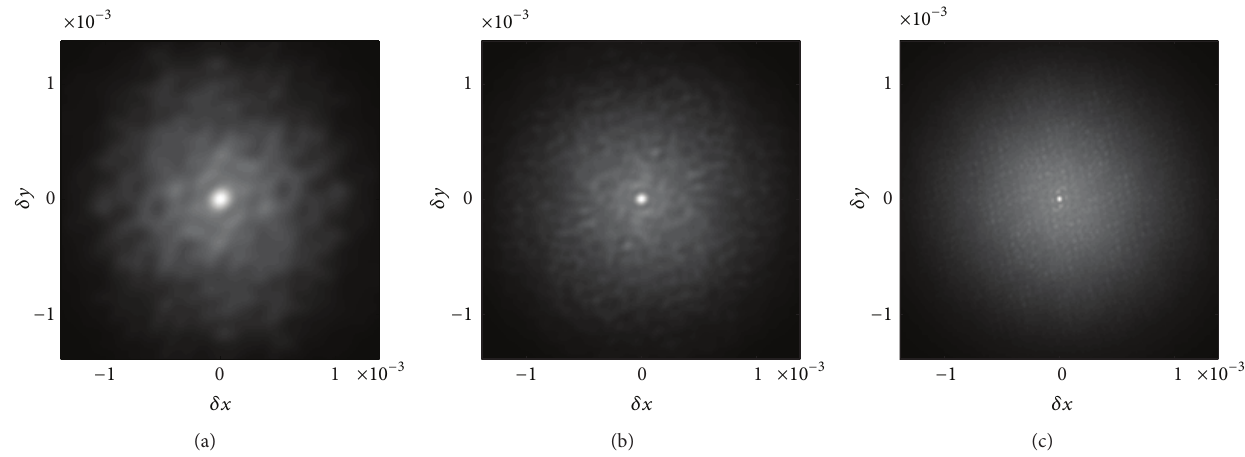
Figure 6: 2D autocorrelations of the interferometric out-of-focus patterns of Figures 3(b), 4(b), and 5(b), respectively. All axes are expressed in